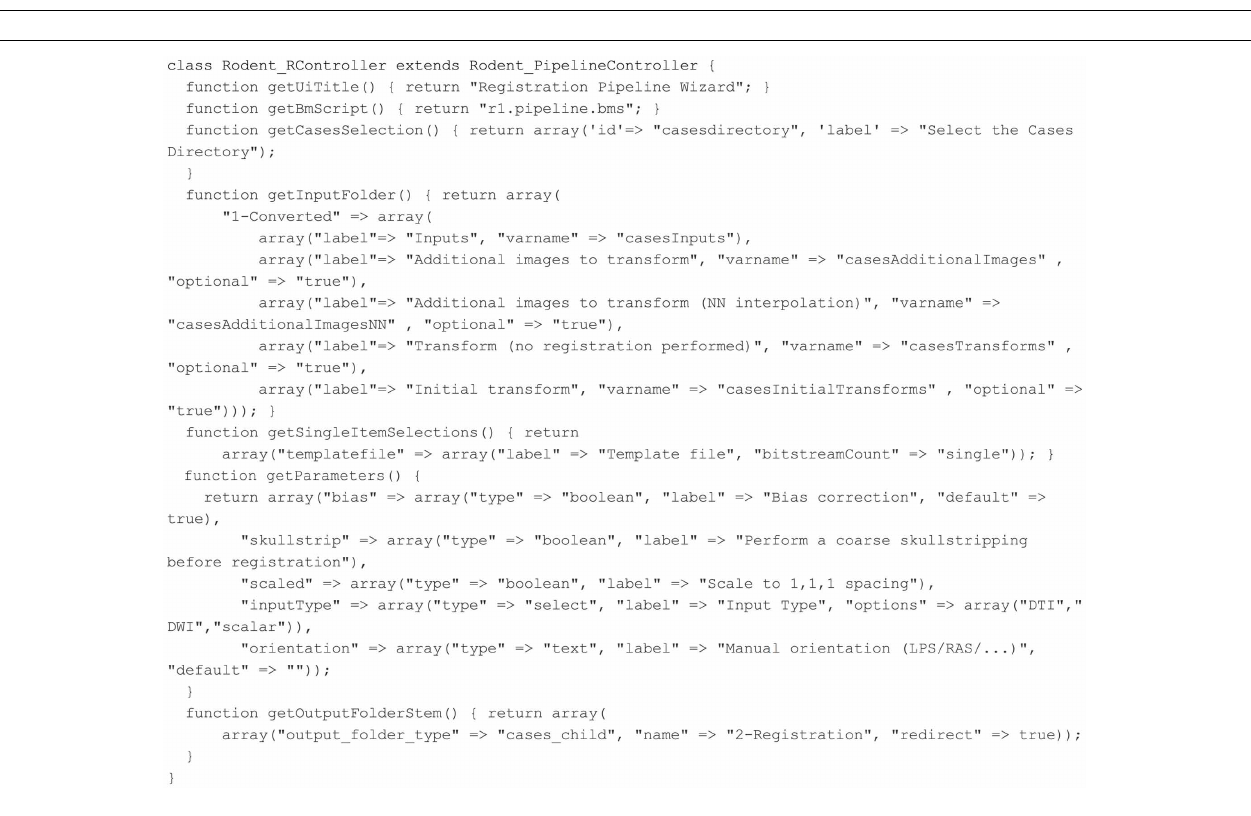
FIGURE 9 | Registration pipeline